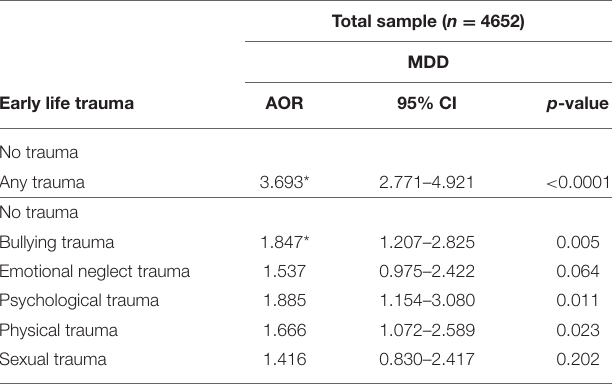
TABLE 2 | Results of multivariable logistic regression analysis of risk of developing major depressive disorder for specific types of reported early life trauma in participants from the Korean Epidemiological Catchment Area Study in 2016 (KECA-2016) ( n = 4652).